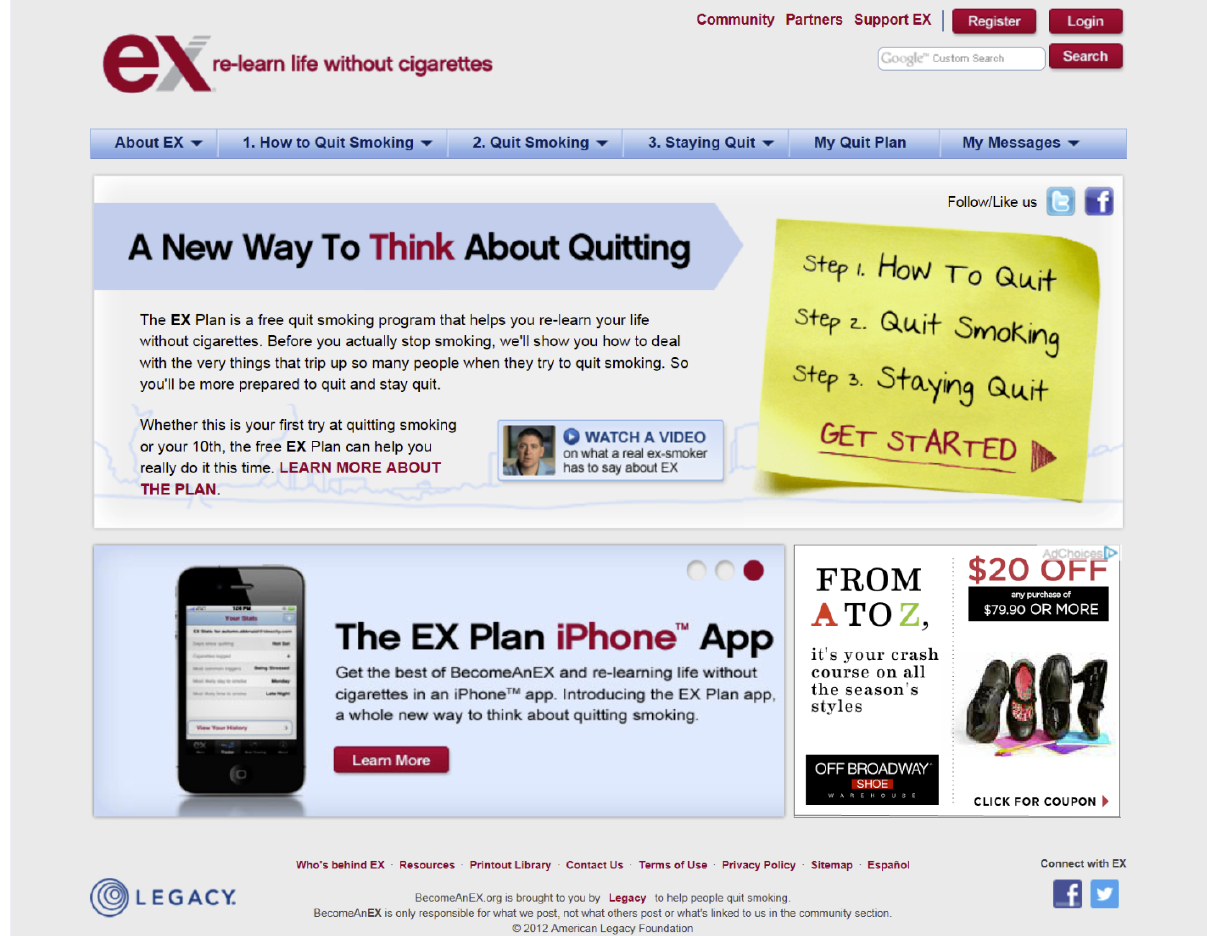
Figure 1. Screenshot of the home page of the BecomeAnEX.org